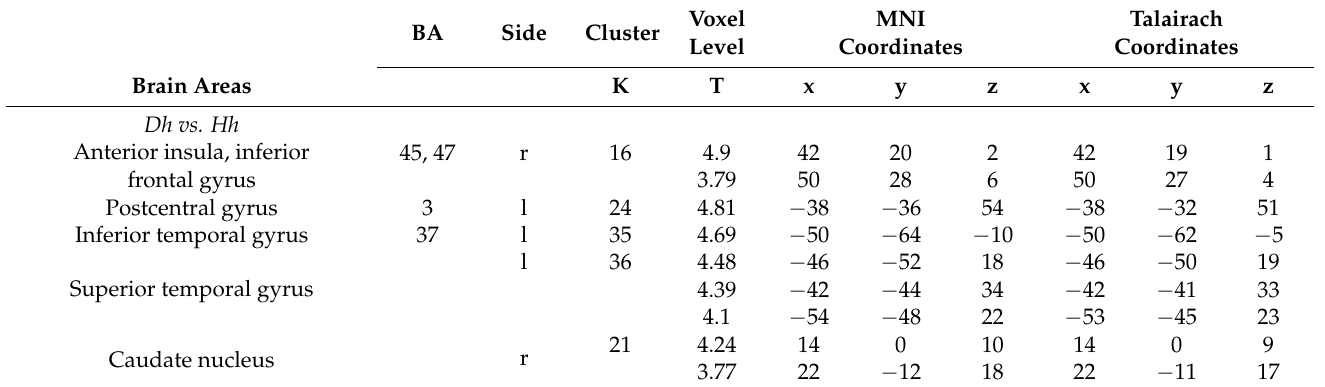
Table 3. Peak coordinates of positive correlation with the Fantasy-Empathy subscale. BA